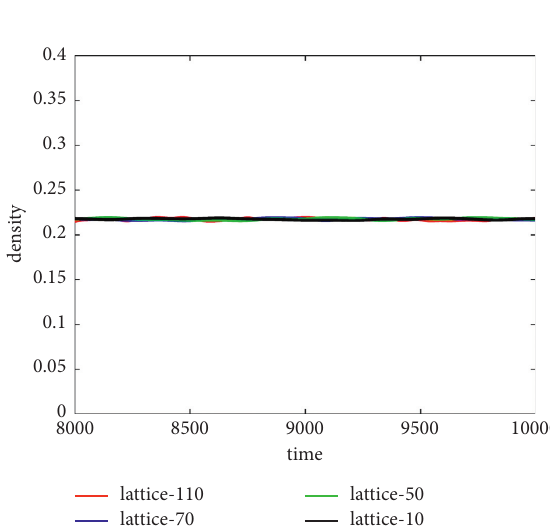
Figure 8: Density evolution diagram.